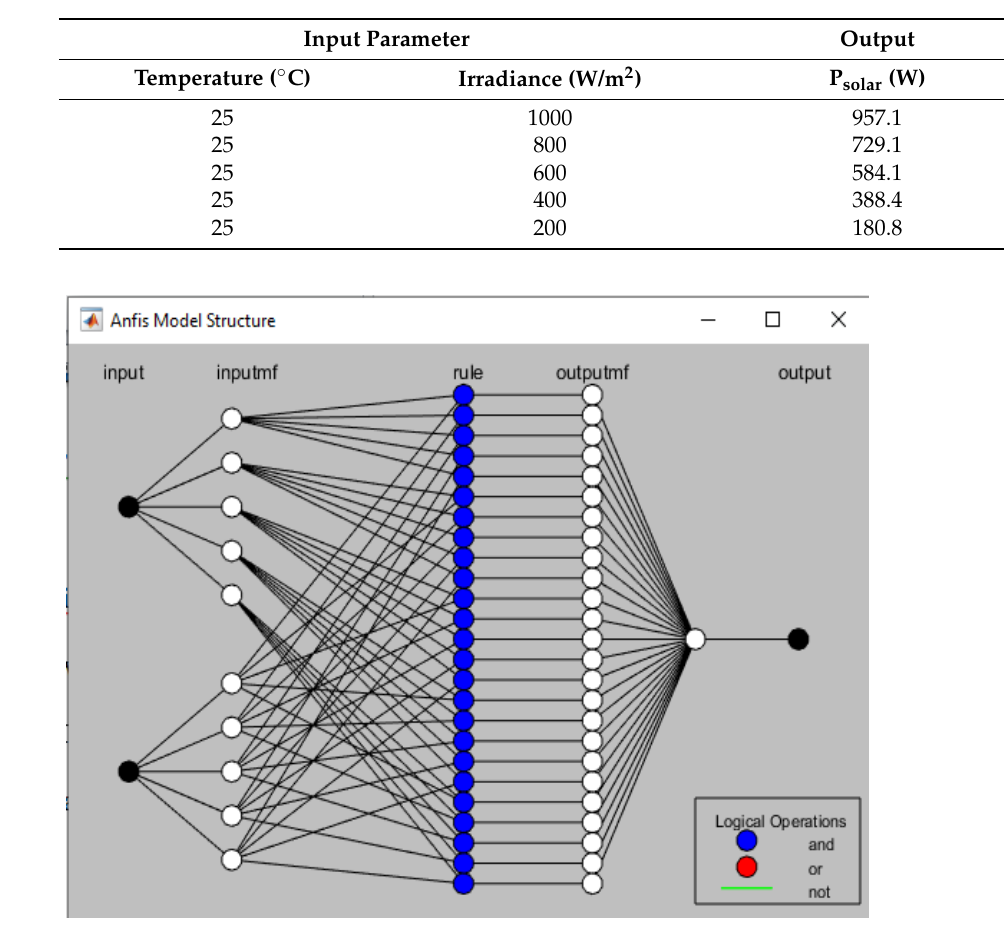
Figure 5. P solar ANFIS model.